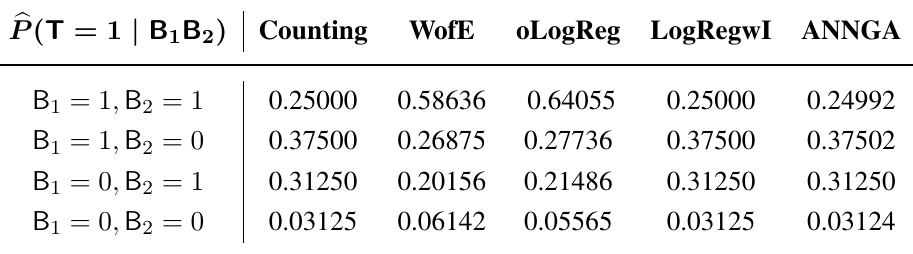
Table 4. Comparison of conditional probabilities predicted with elementary